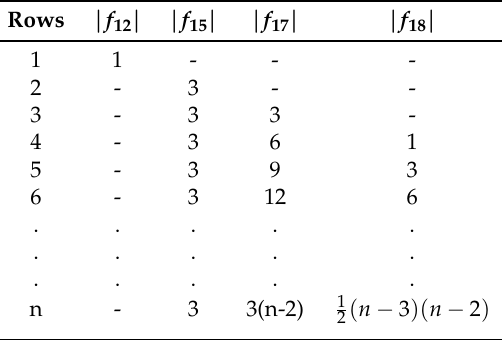
Table 3. Number of f 14 , f 15 , f 17 , f 18 in each row.